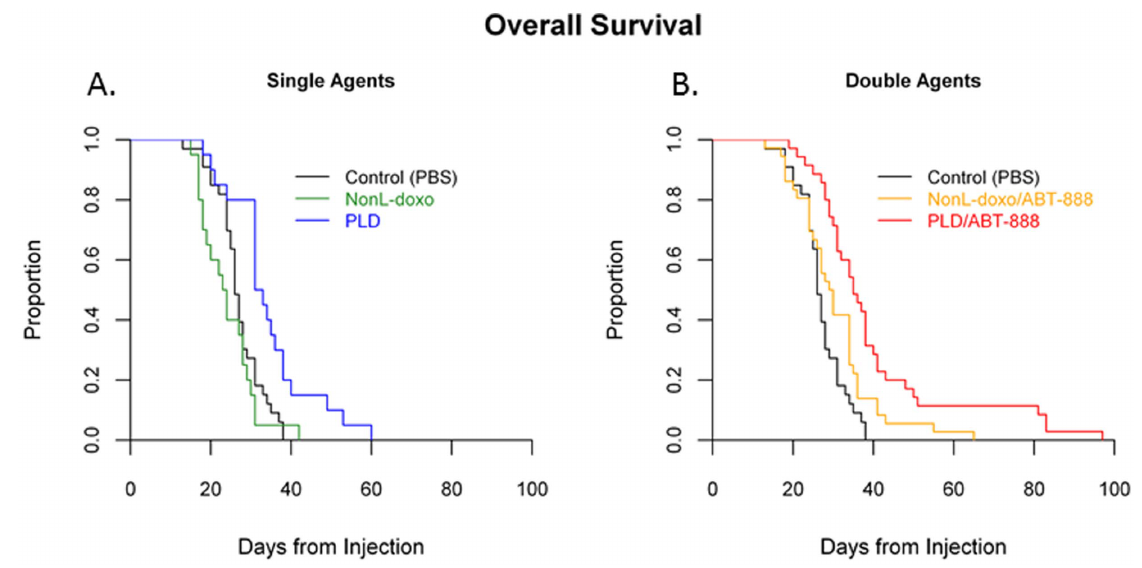
Figure 3. Efficacy Studies in an intracranial model of breast cancer. ( A ) Median survival (from the time of intracranial cell line injection) of animals treated with control (PBS, black), non-liposomal doxorubicin (NonL-doxo, green) 6mg/kg IV weekly and PEGylated liposomal doxorubicin (PLD, blue) 6mg/kg IV weekly in a murine model of intracranial breast cancer. ( B ) Median survival of animals treated with control (PBS, black), NonL- doxo 4.5 mg/mg IV weekly plus ABT-888 25 mg/kg OG daily (yellow) versus PLD (red) 4.5mg/mg IV weekly plus ABT-888 25 mg/kg OG daily in a murine model of intracranial breast cancer.